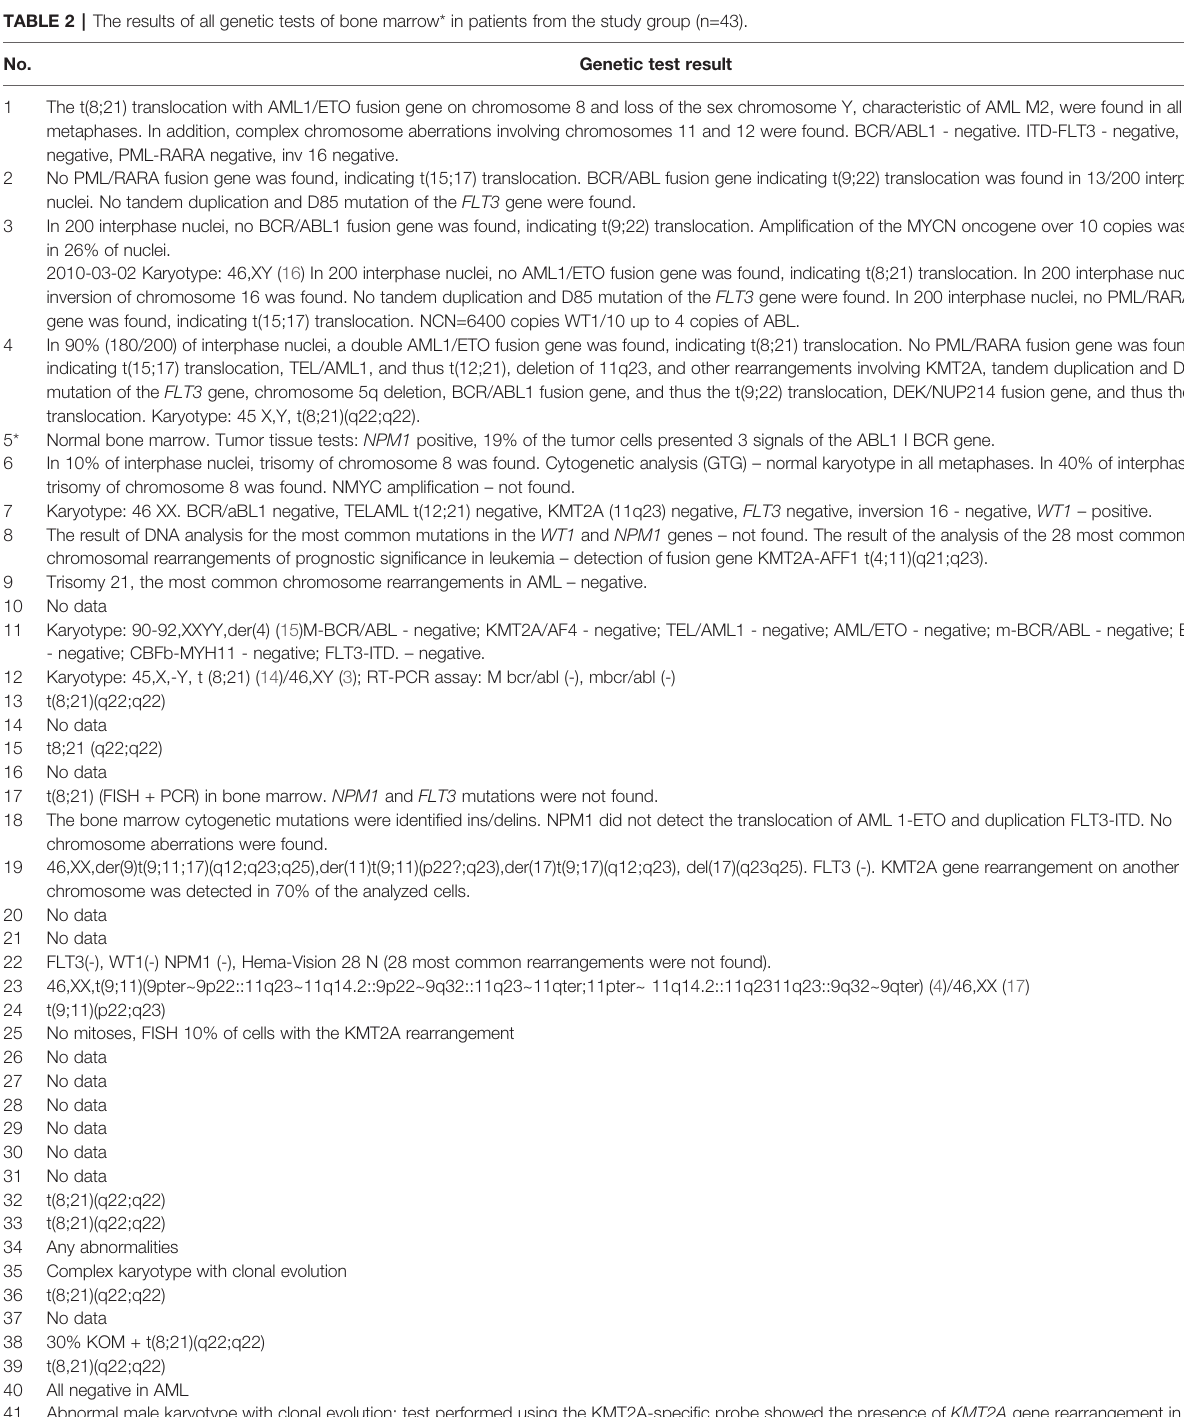
TABLE 2 | The results of all genetic tests of bone marrow* in patients from the study group (n=43). No. Genetic test